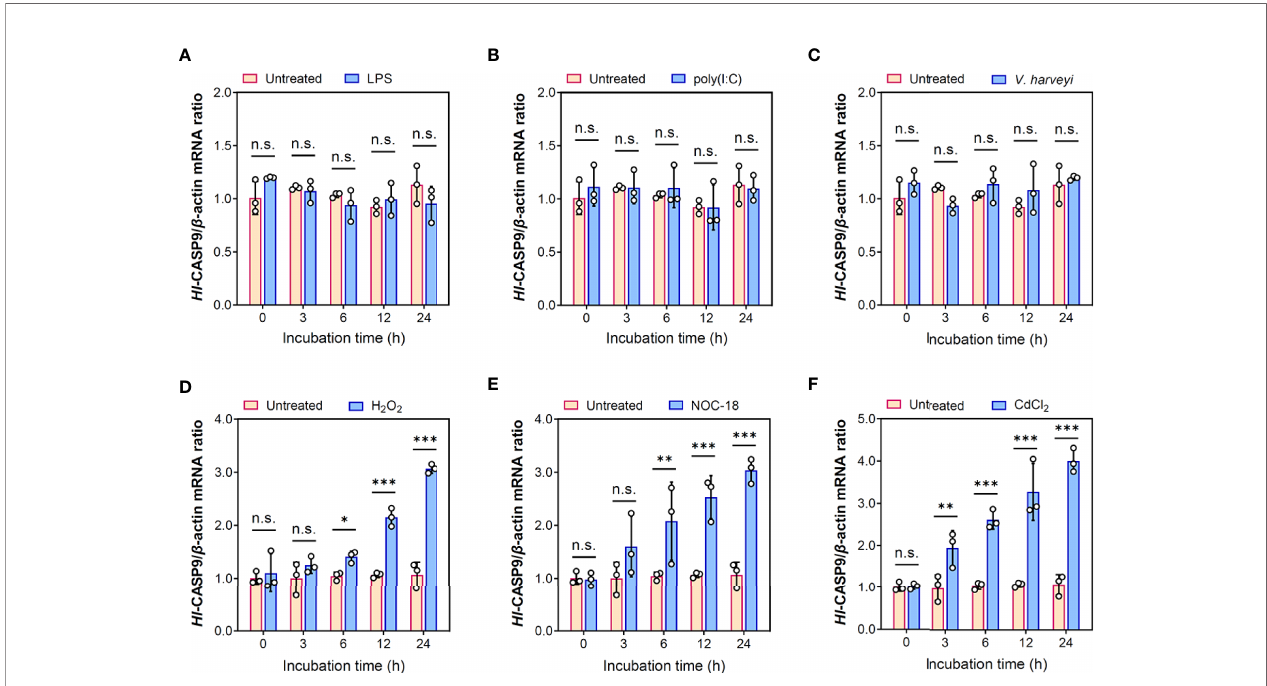
FIGURE 4 | Transcriptional expression patterns of Hl-CASP9 following challenges of immunostimulants or oxidative stress inducers. (A) Time-course study on the expression of Hl-CASP9 mRNA in coelomocytes treated with LPS (10 m g/mL). (B) Time-course study on the expression of Hl-CASP9 mRNA in coelomocytes treated with poly(I:C) (10 m g/mL). (C) Time-course study on the expression of Hl-CASP9 mRNA in coelomocytes treated with inactivated V. harveyi (10 7 cells/mL). (D) Time- course study on the expression of Hl-CASP9 mRNA in coelomocytes treated with H 2 O 2 (2 m M). (E) Time-course study on the expression of Hl-CASP9 mRNA in coelomocytes treated with NOC-18 (1 m M). (F) Time-course study on the expression of Hl-CASP9 mRNA in coelomocytes treated with CdCl 2 (20 m